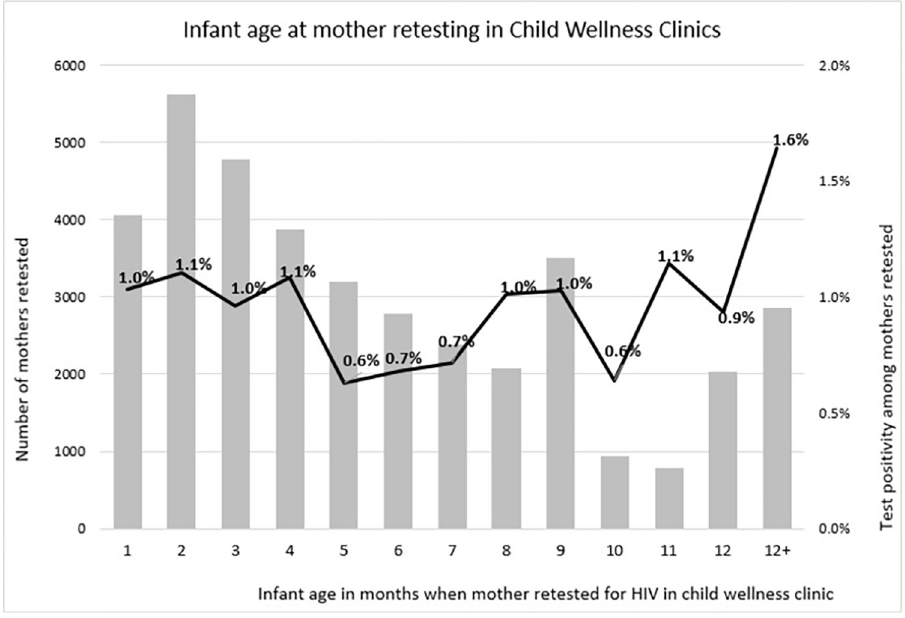
Fig 4. Number of mothers retested for HIV in child welfare clinics and test-positivity among mothers according to age of infant, Nampula, Mozambique, July-November, 2019.